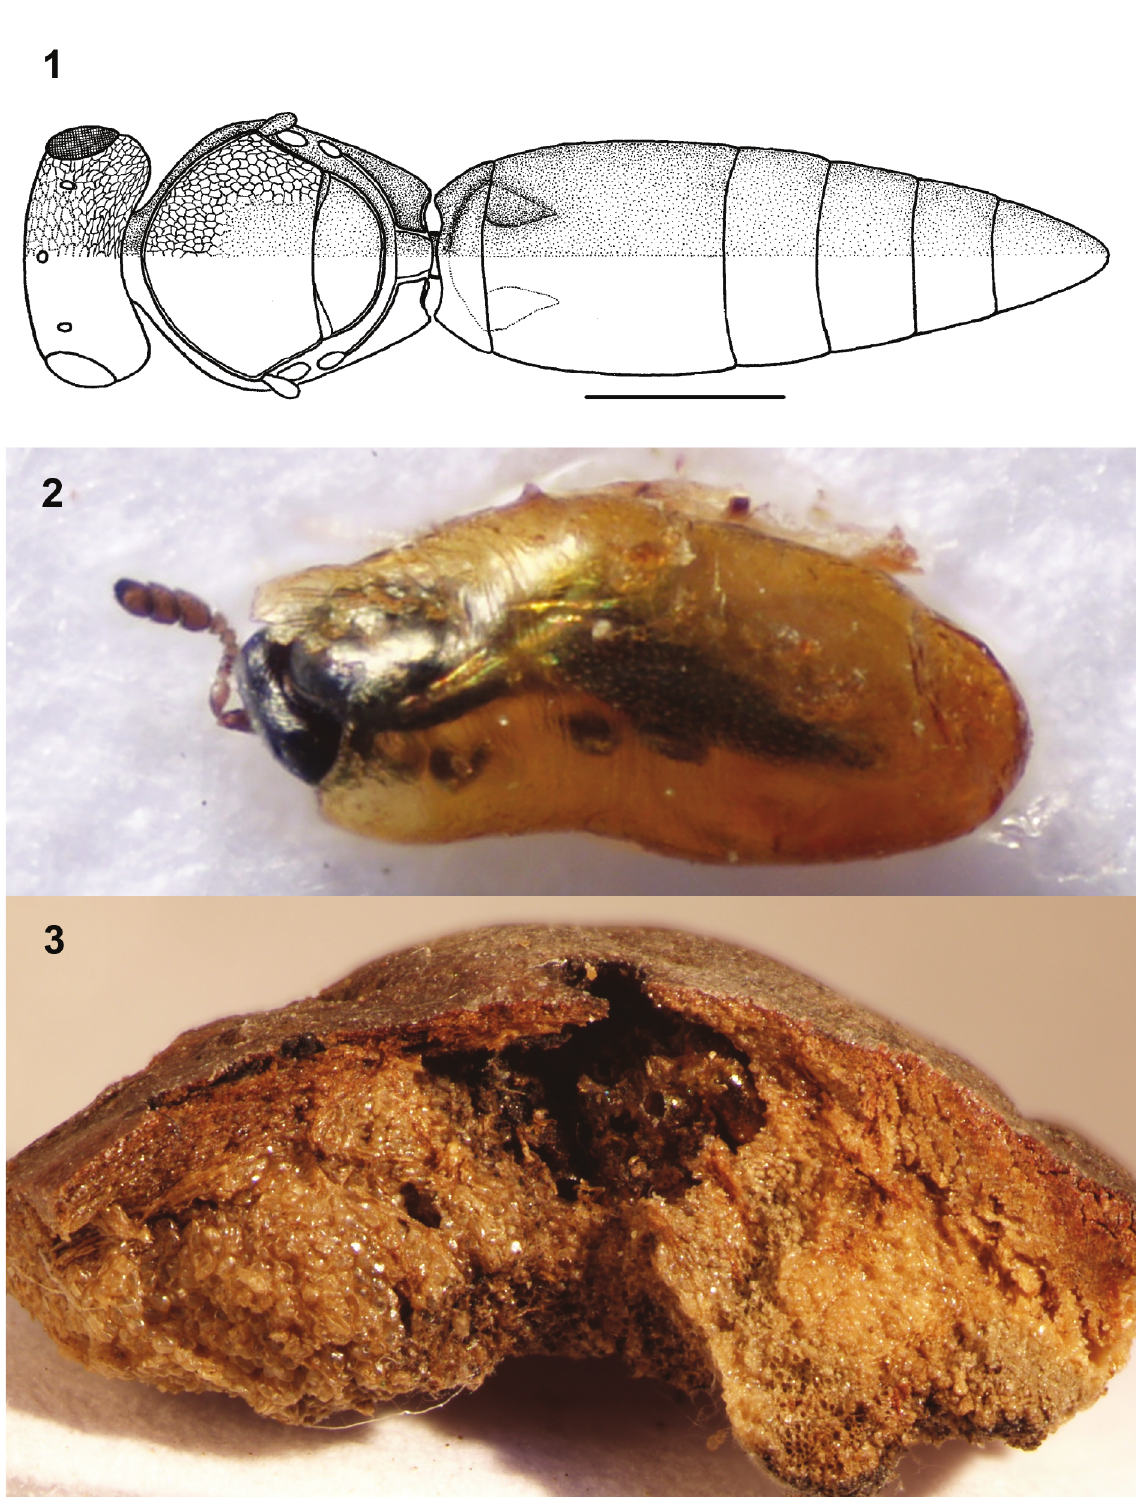
Figs 1–3. Fidiobia hispanica Popovici & buhl, 2010. 1 . Dorsal habitus, ♀. 2 . host egg with half emerged ♀. 3 . Fragment of old Andricus kollari gall showing cavity - a vacated cell of Synergus umbraculus – containing beetle eggs, the true host of F. hispanica . body length of wasp c . 0.8 mm. ©